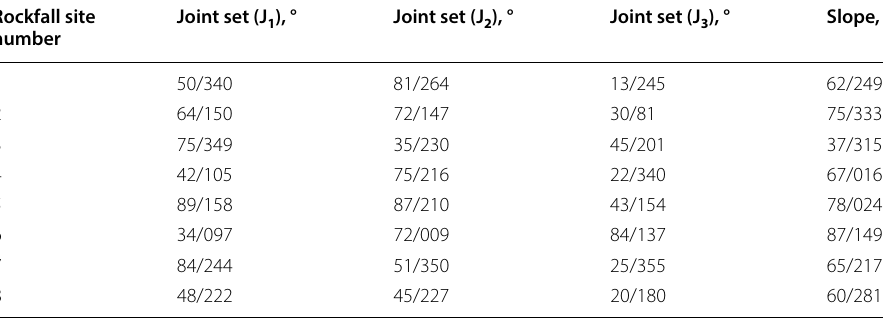
Table 3 Dominant joint set data at eight rockfall sites Rockfall site